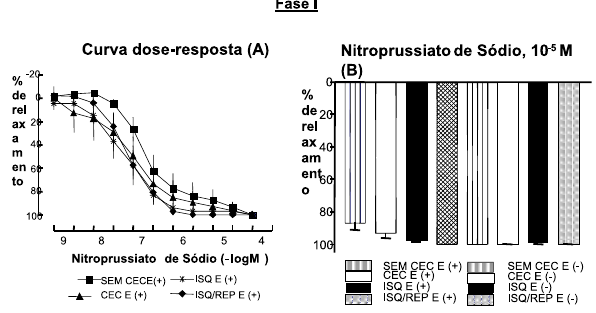
Fig. 10 - Fase I (Krebs com magnésio): A - Curvas dose- respostas ao nitroprussiato de sódio (NPS) em anéis de artérias coronárias caninas, contraídas com PGF a (2 x 10 -6 M), na 2 presença de indometacina (10 -5 M); B - Efeitos da dose 10 -6 M de nitroprussiato de sódio (NPS) de em anéis de artérias coronárias caninas, contraídas com PGF2a (2 x 10 -6 M), na presença de indometacina (10 -5 M); (SEM CEC = grupo controle, CEC = grupo de animais submetidos a 110 min de circulação extracorpórea, ISQ = grupo de animais submetidos a 45 min de isquemia, ISQ/REP = grupo de animais submetidos a 45 min de isquemia e 60 min de reperfusão, E (+) = anéis com endotélio, E (-) = anéis sem endotélio. Valores em porcentagem de relaxamento sob a forma de médias ± erros-padrão ). (n =